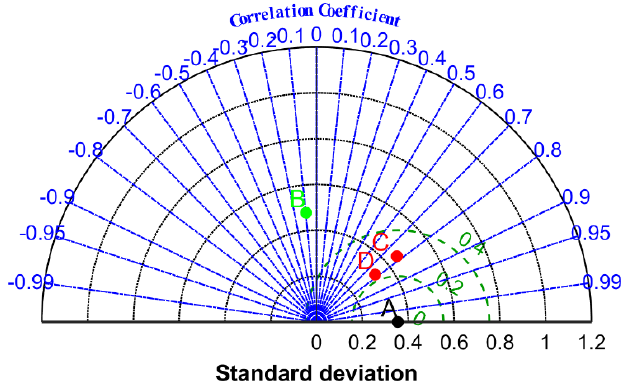
Figure 8. Taylor diagram of simulated chlorophyll-a concentration with respect to (A) the observations of marine ranches, (B) the simulated results without parameter optimization, (C) the simulated results with constant parameters optimized, (D) with spatially varying parameters optimized. RMSD represents the root mean square